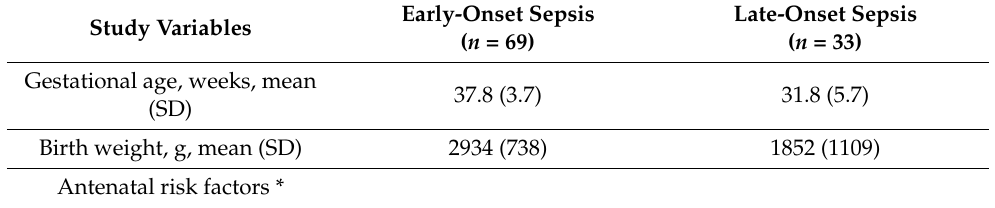
Table 2. Clinical and laboratory data in infants with suspected neonatal sepsis. Study